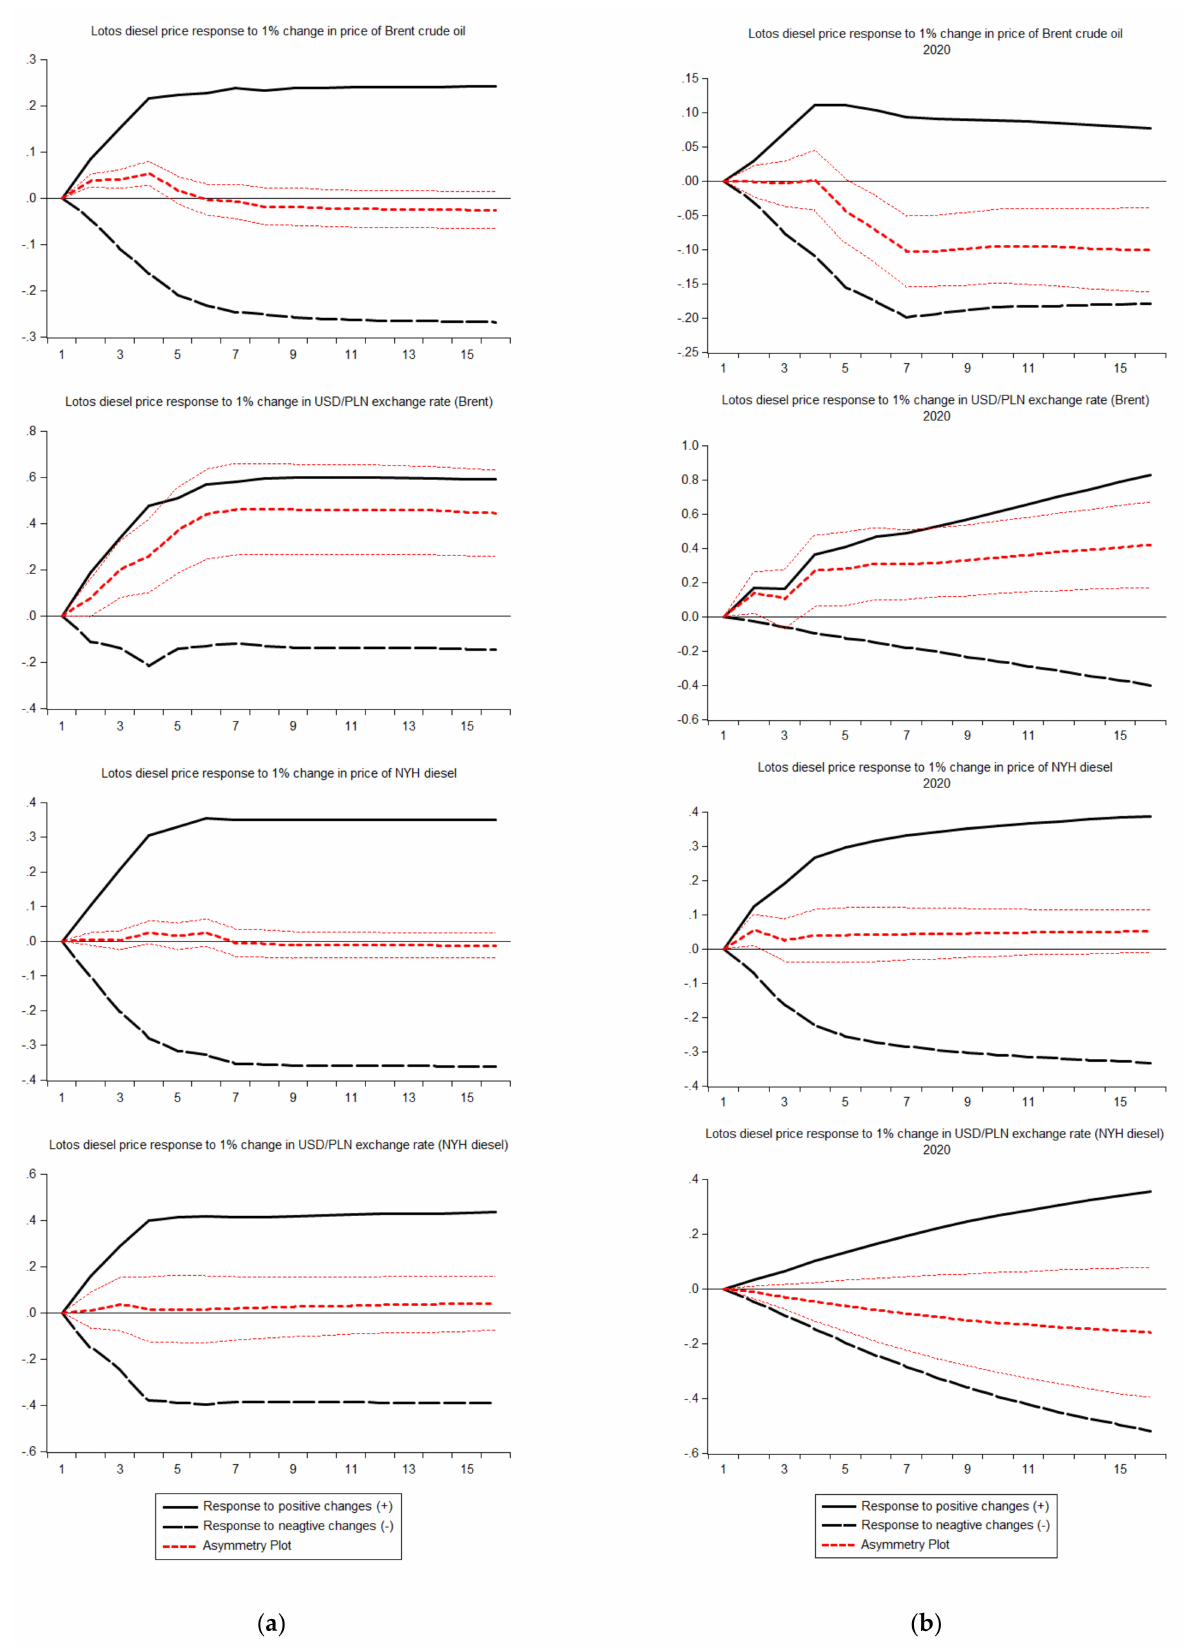
Figure 11. Dynamic multipliers for Lotos Diesel ( a ) whole sample; ( b ) year